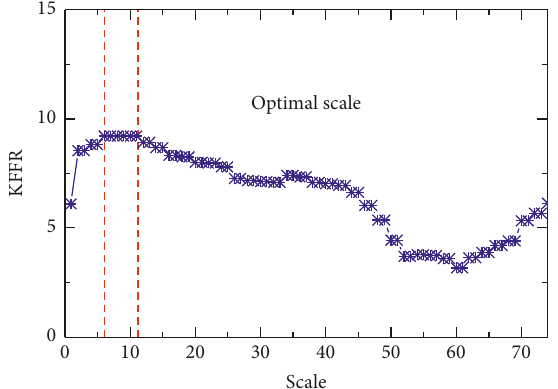
Figure 13: Case 1: KFFR values of filtering results with different scales.